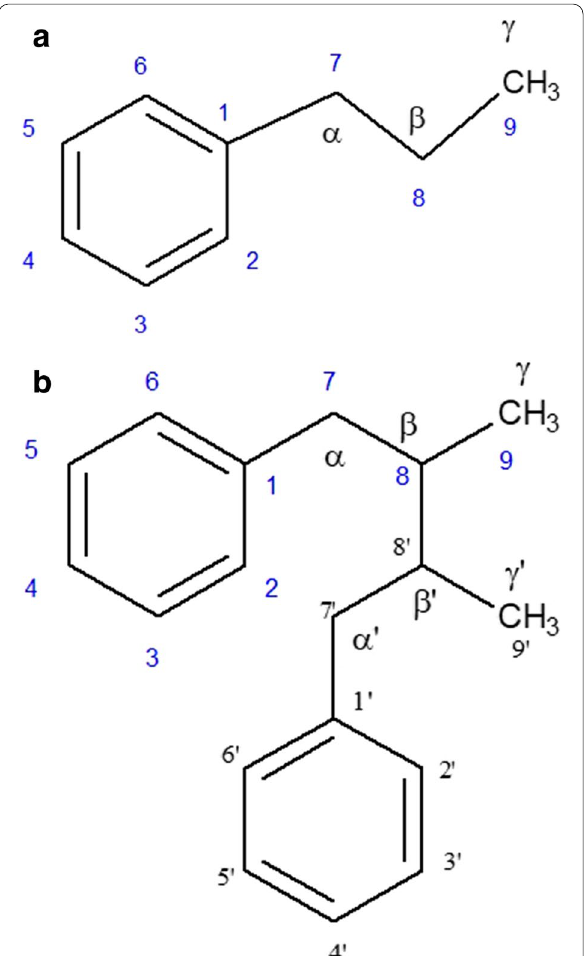
Fig. 2 a Phenylpropane unit. b Dimer of C6-C3 unit via β-β ′